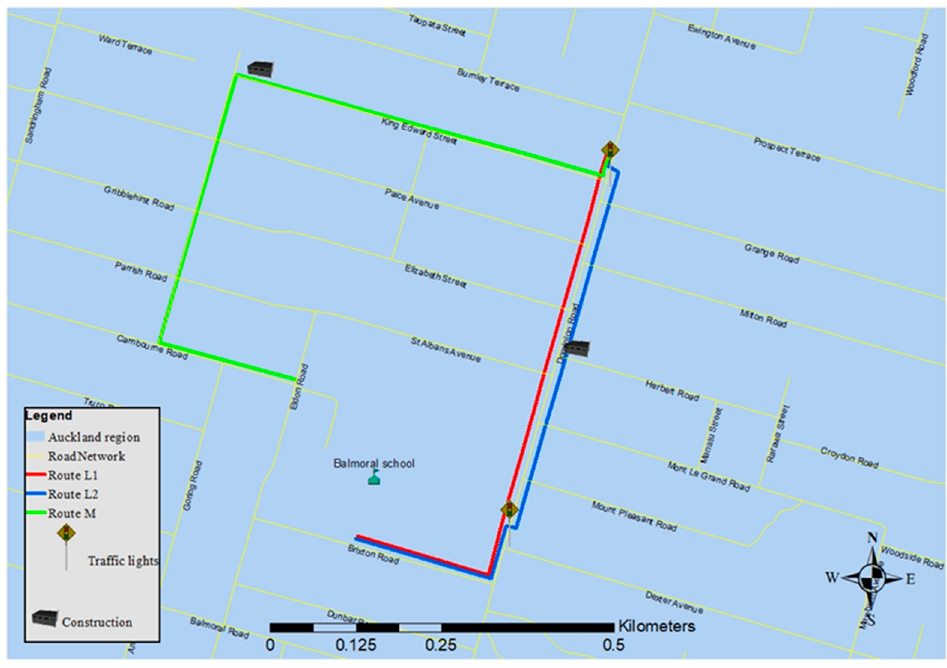
Figure 1. The map of the routes. Major segment of two Routes (L1 and L2) includes a high trafficked road (Dominion road), and Route M passes through the quiet streets.